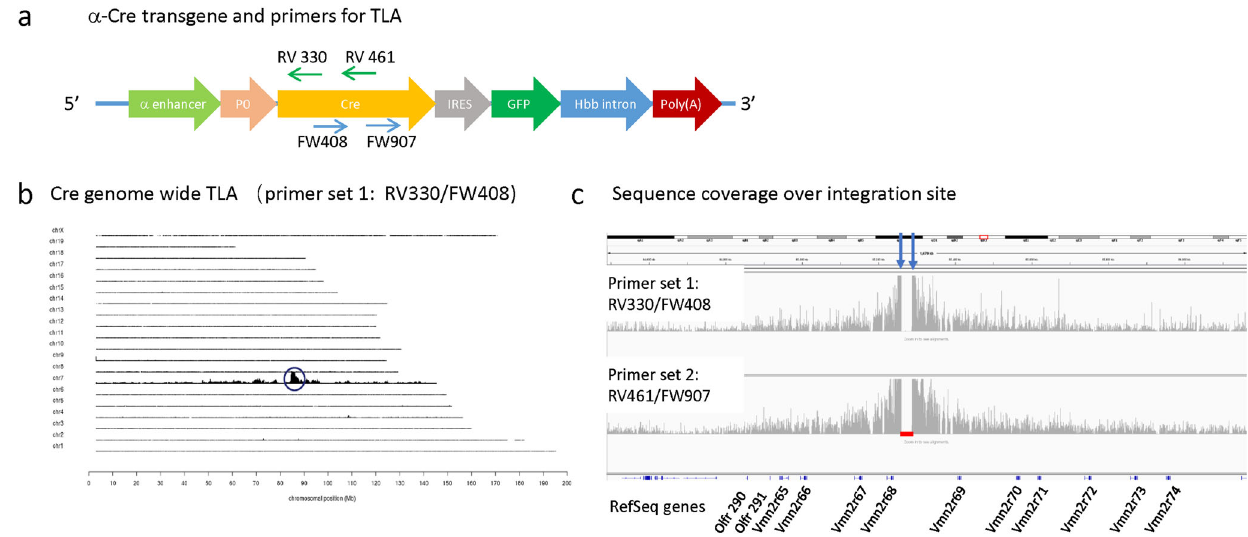
Fig. 1 α -Cre locus identi fi cation. a Schematic of the vector used to make α -Cre mice (including Pax6 α -enhancer, Pax6 P0 promoter, Cre, IRES, GFP, Hbb intron, and SV40 poly A sequence), showing positions of primers within Cre used for TLA. b TLA sequence coverage across the mouse genome using primer set 1. The chromosomes are indicated on the y -axis, the chromosomal position on the x -axis. Similar results were obtained with primer set 2. Peak at Chromosome 7 shows inserted sequence (black circle). c Regional coverage of the α -Cre insertion site on Chromosome 7 using both sets of primers, showing a 27 kb deletion and spanning 2 Mb. Some RefSeq genes fl anking the insertion site (version Mm10) are also